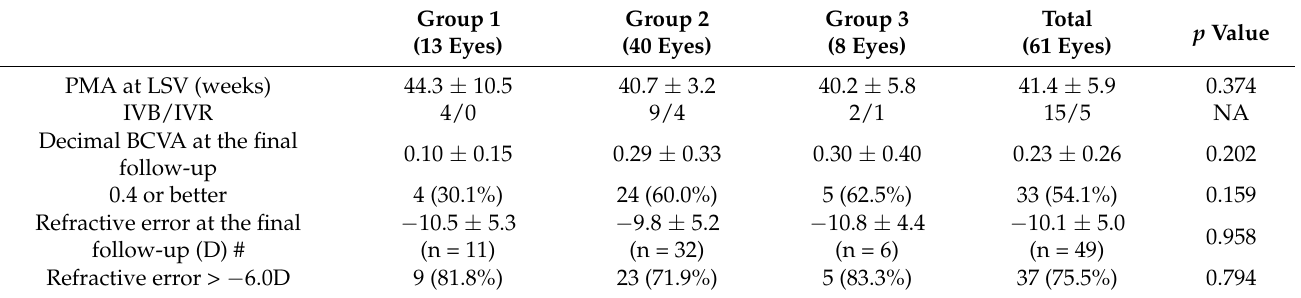
Table 2. Ocular characteristics of eyes after successful lens-sparing vitrectomy for stage 4A retinopa- thy of prematurity.